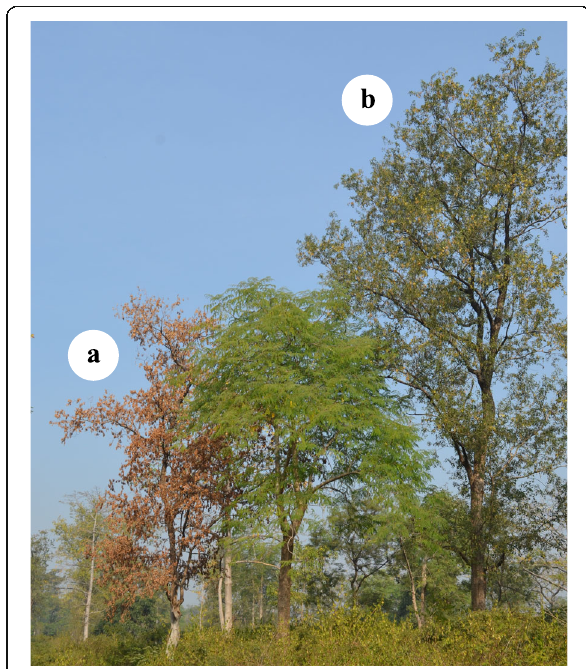
Fig. 1 D. sissoo completely wilted (a) and healthy (b) trees in their natural habitat (riverine forest) Thano forest range, Dehra Dun, India